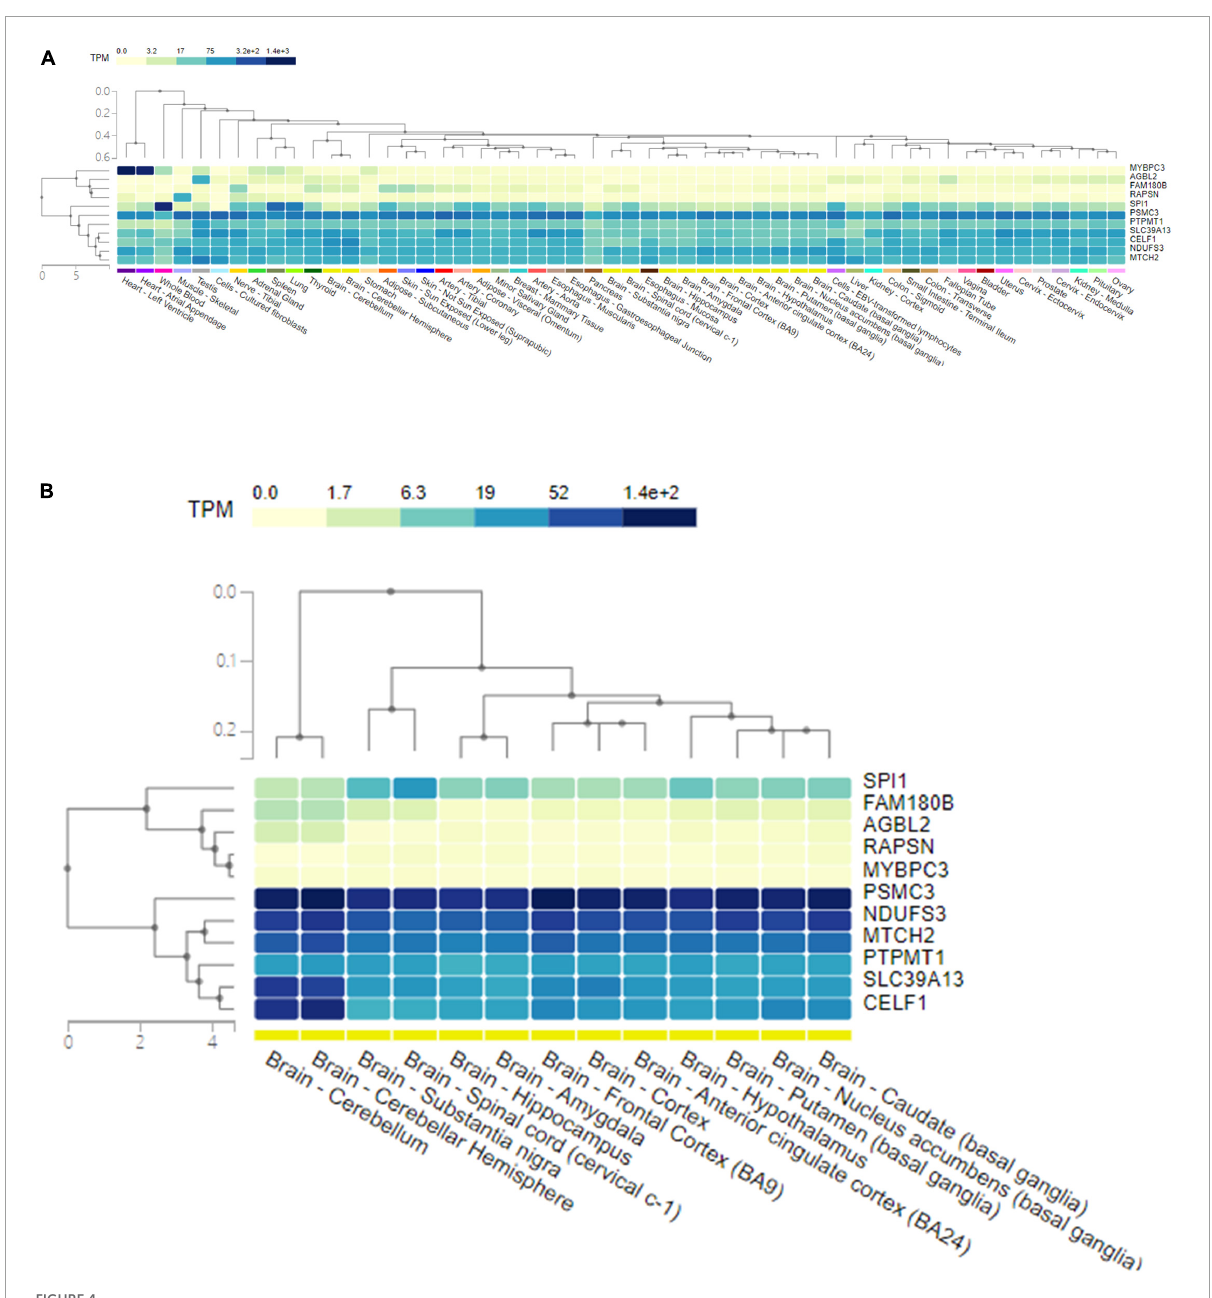
FIGURE4 The expression level of 11 pleiotropic genes shared by AD and glaucoma in human tissues. (A) A heat map of the expression level of 11 pleiotropic genes shared by AD and glaucoma in all human tissues. The shared genes and the detected tissues were clustered by hierarchical clustering. The corresponding expression level of the gene in tissue was colored according to the linear count of the indicated TPM. (B) A heat map of the expression level of 11 pleiotropic genes shared by AD and glaucoma in human brain tissues. The shared genes and the detected brain tissues were clustered by hierarchical clustering. The corresponding expression level of the gene in brain tissue was colored according to the linear count of the indicated TPM. TPM represents transcript per